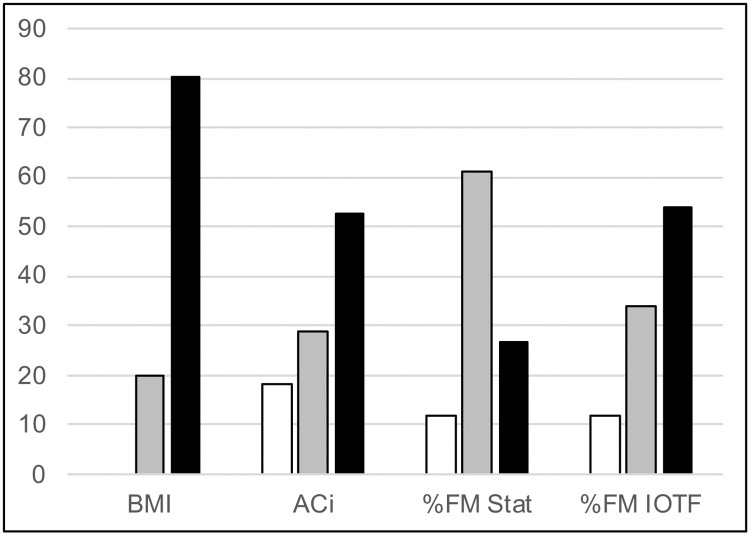
Nutritional classification of total sample based on the Z-BMI, the Z-abdominal circumference and the Z-% fat mass.The bars represent percentage of children. Black bars: obesity or abdominal obesity; grey bars: overweight, excess of central fat mass or overfat; white bars: normal central fat mass or normal fat. BMI: body mass index; ACi: abdominal circumference; FM: fat mass; Stat.: cut-offs according to the statistical criteria; IOTF: cut-offs according to the IOTF criteria.